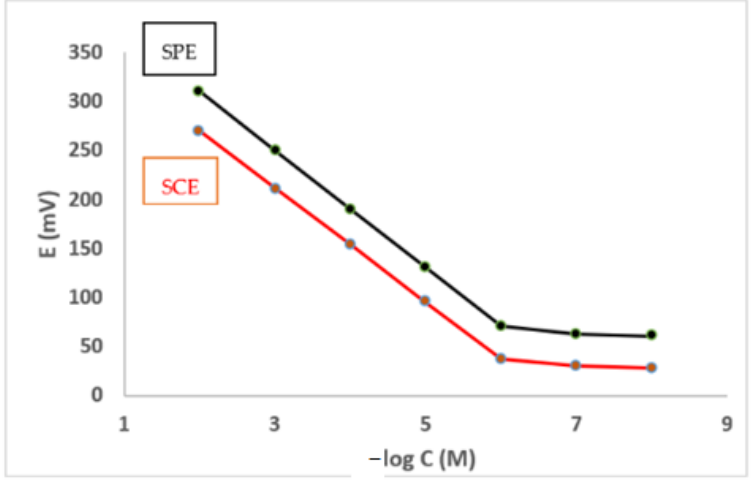
Figure 3. Calibration graphs for the BRZ electrodes at 25 °C.